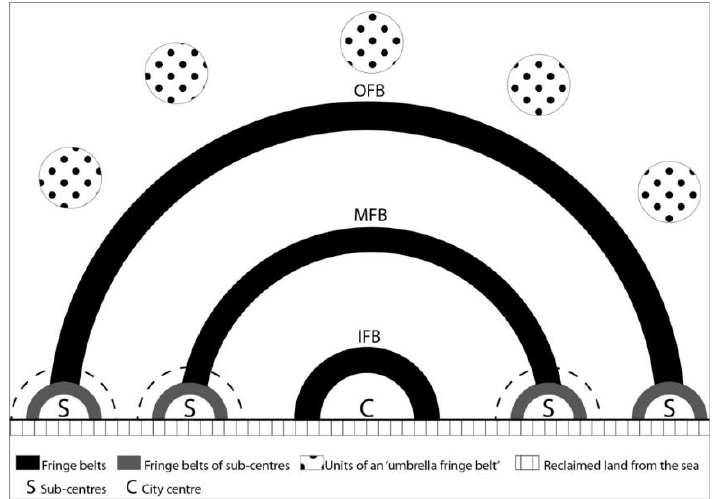
Figure 6 The umbrella fringe-belt model for the development of cities at the metropolitan